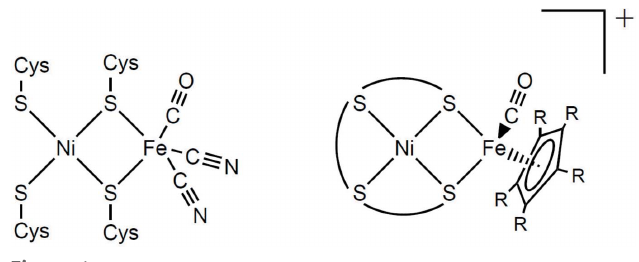
Figure 1 Structure of the NiFe hydrogenase active site (left) and general model of the type [Ni(‘S 4 ’)Fe(Cp R )(CO)] + (right; ‘S 4 ’ = synthetic tetrasulfur donor